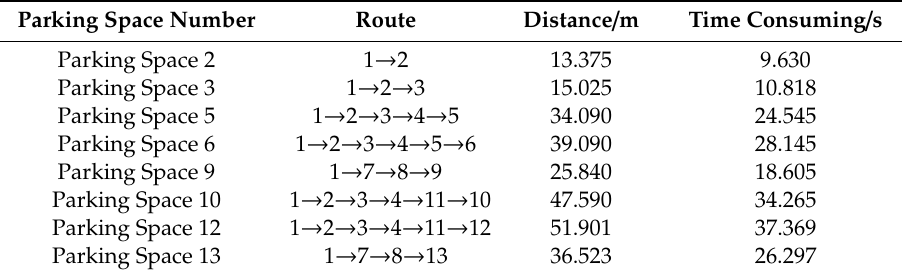
Table 7. Driving route of each parking space under the improved